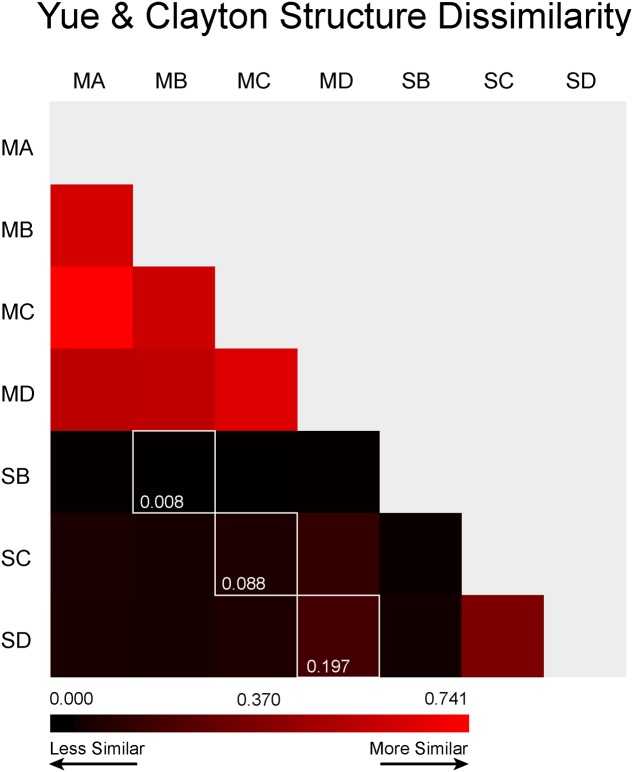
Community Structure Dissimilarity. This calculation was made using Yue and Clayton (2005) indices at a clustering distance of ≤0.03. The colors are scaled to the highest level of similarity between any two samples (red) and the lowest level of similarity (black). The white outline represents the direct comparison between the meteorite and its underlying soil.